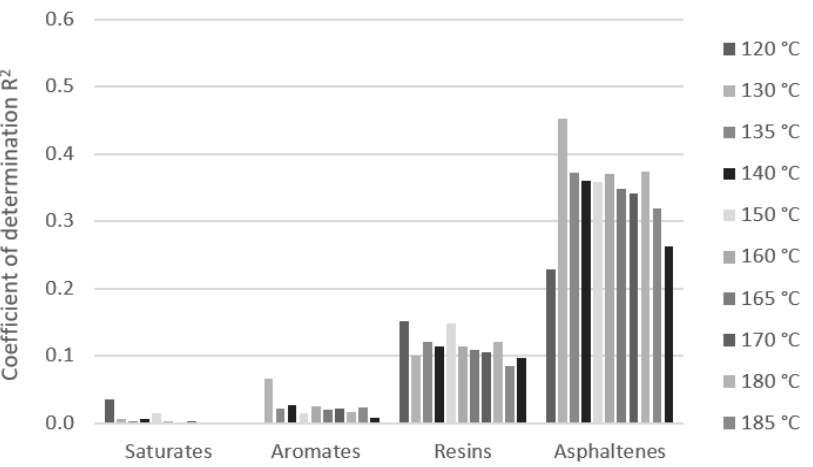
Figure 11. Coefficient of determination of linear model of dynamic viscosity and SARA composition at temperatures in the range 120 to 190 ◦ C for group paving grade bitumen samples (50/70 and